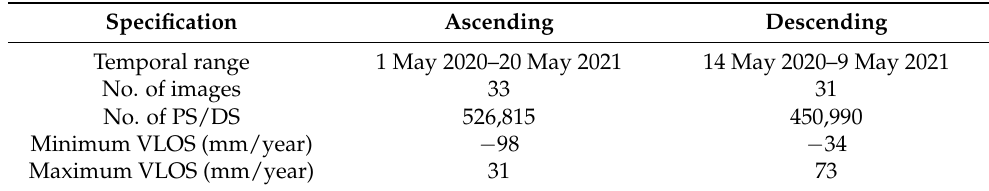
Table 4. Details of PS-InSAR